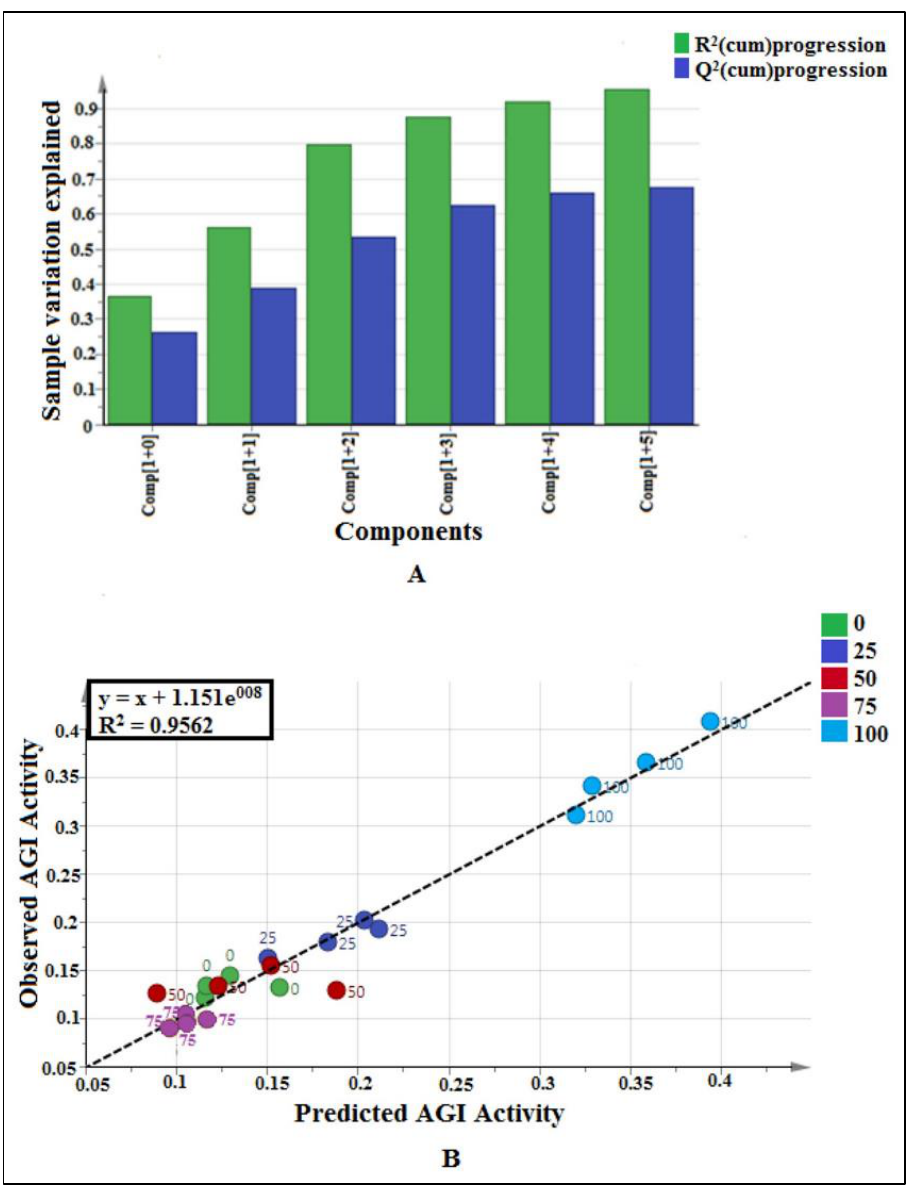
Figure 5. ( A ) Summary of fit of established OPLS model for P. malayana leaves extracts ( n = 4), where six principle components involved and this plot indicate the fitness of the model. ( B ) Observed vs. predicted AGI activity with R 2 value 0.9562 from 20 extracts of P. malayana leaves ( n = 4), indicating the model was valid.